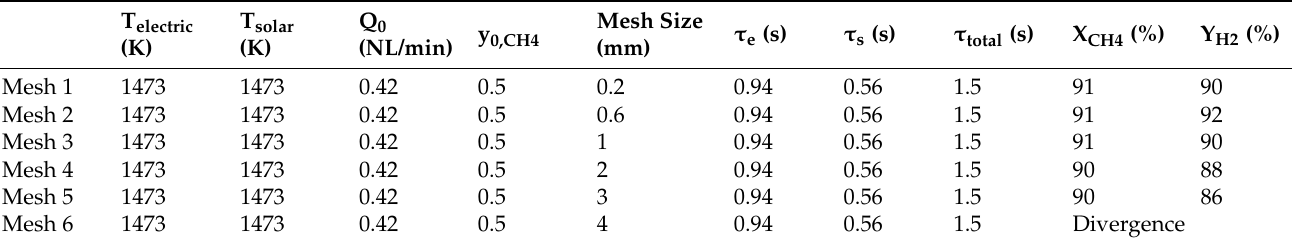
Table 3. Study of the meshing influence on the CFD numerical